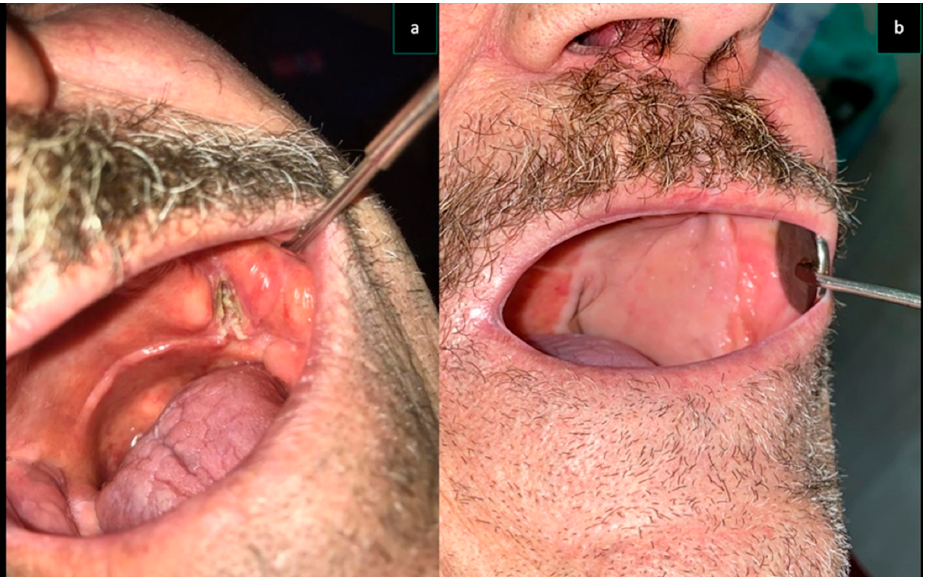
Figure 4. Same patient as Figure 2 (Case 3) ( a ) Intra-oral aspect of the cancer involving left tuber maxillae and cheek. The reconstruction performed with STAP flap ( b ).